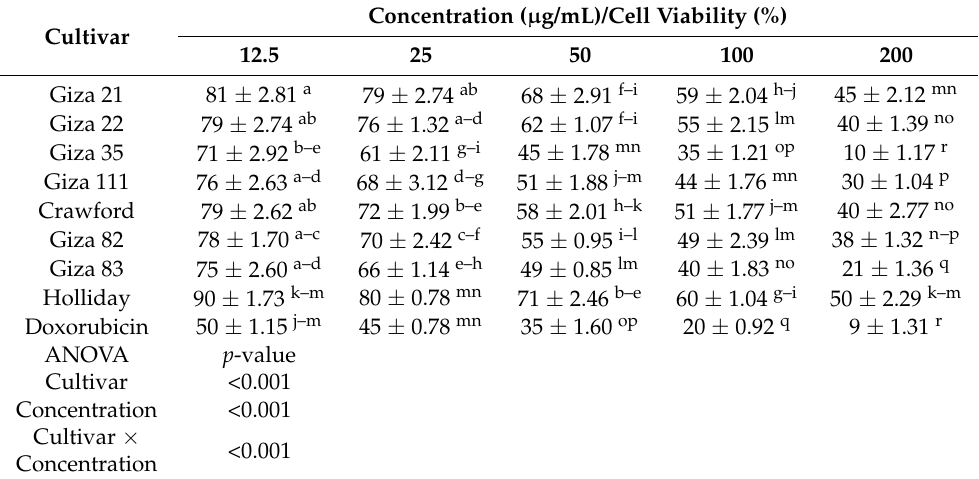
Table 6. The percentage of HepG-2 viability as affected by soybean methanolic extracts at different concentrations (12.5, 25, 50, 100, and 200 µ g/mL) from eight soybean cultivars compared to that of the control (Doxorubicin).